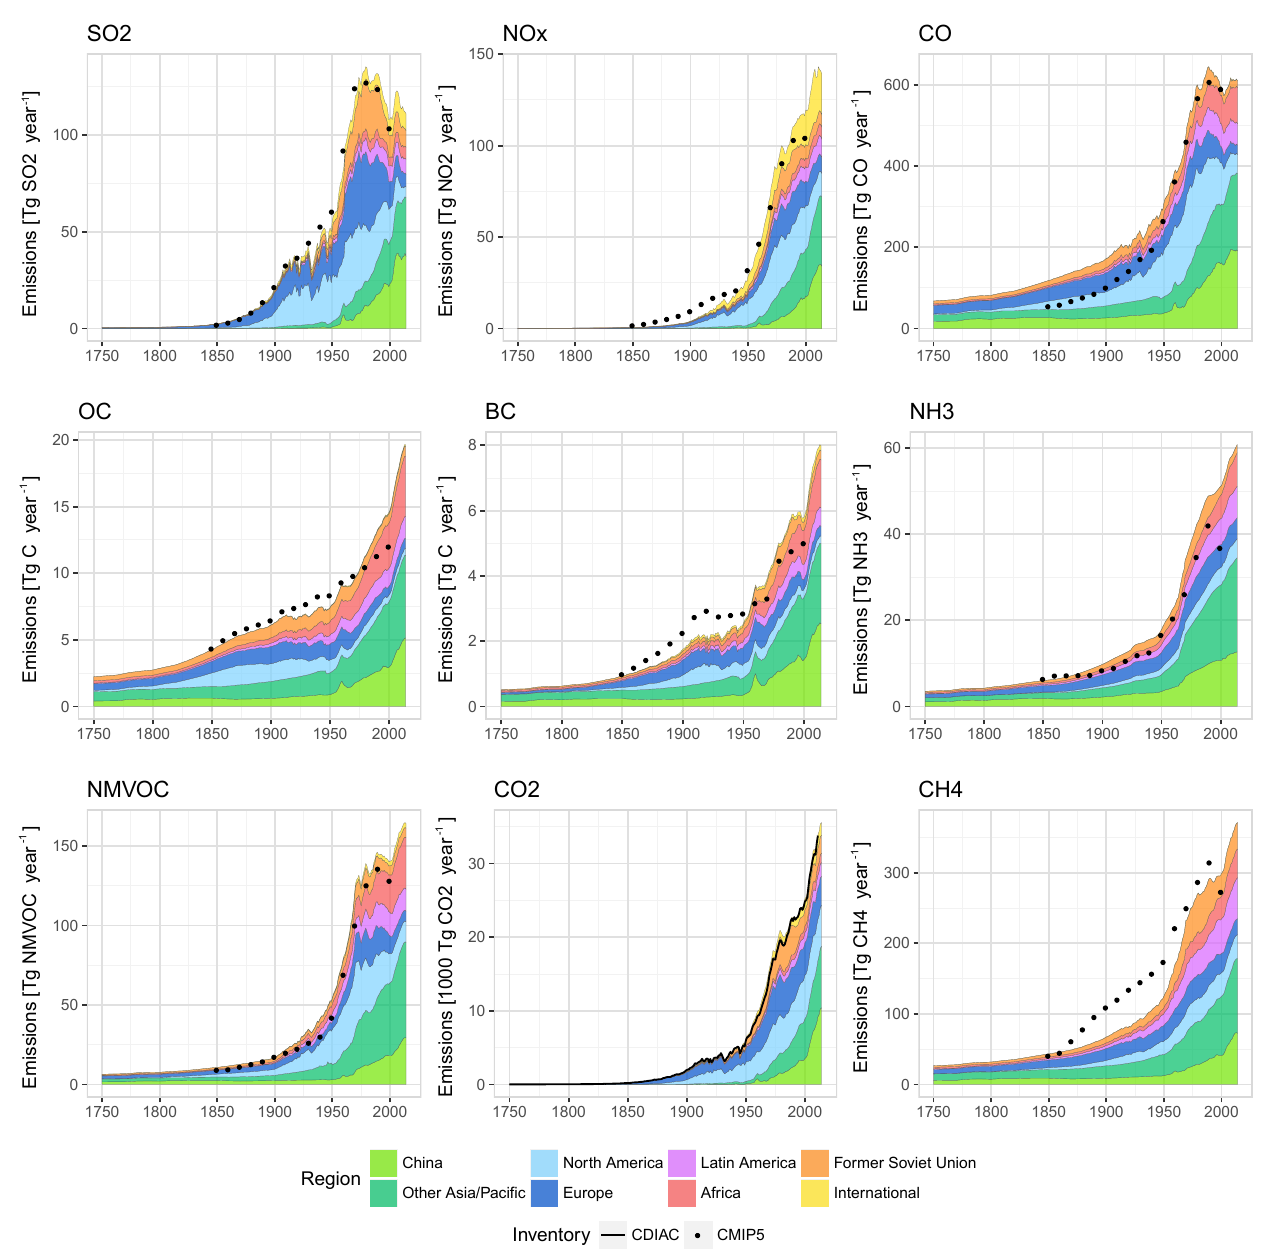
Figure 3. Emission estimates by region compared to Lamarque et al. (2010) (dots) and CDIAC (line) for CO 2 . For a like-with-like compar- ison, these figures do not include aviation or agricultural waste burning on fields. The “International” region shows international shipping